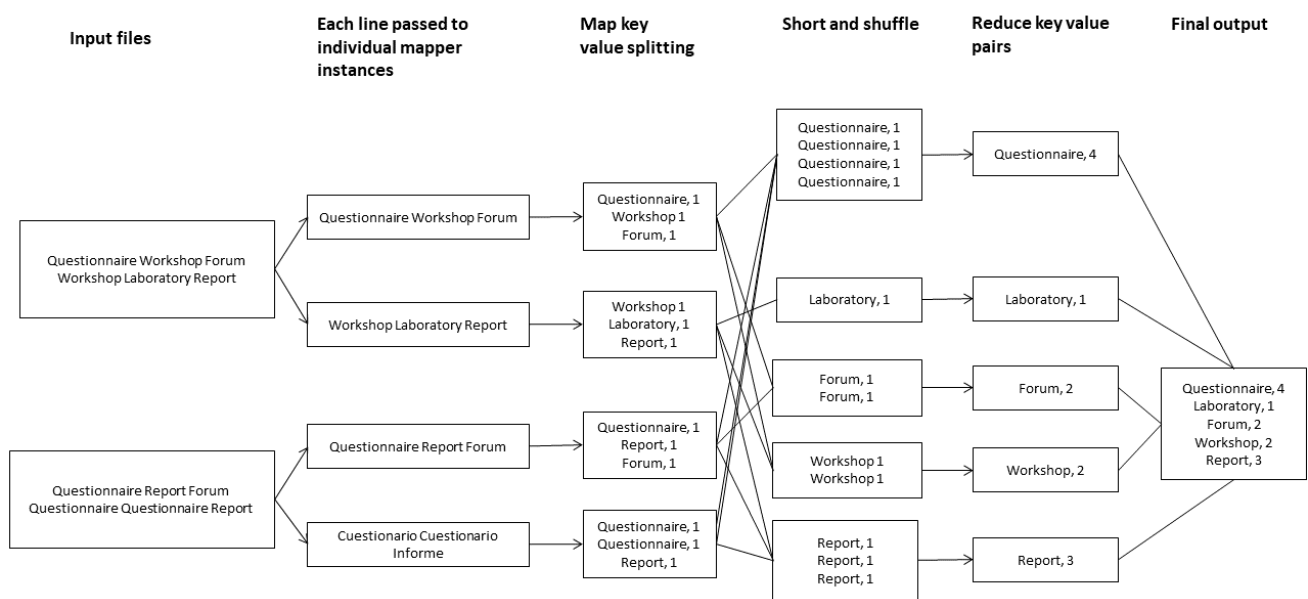
Figure 10. Data processing, through MapReduce, an example with academic activities.